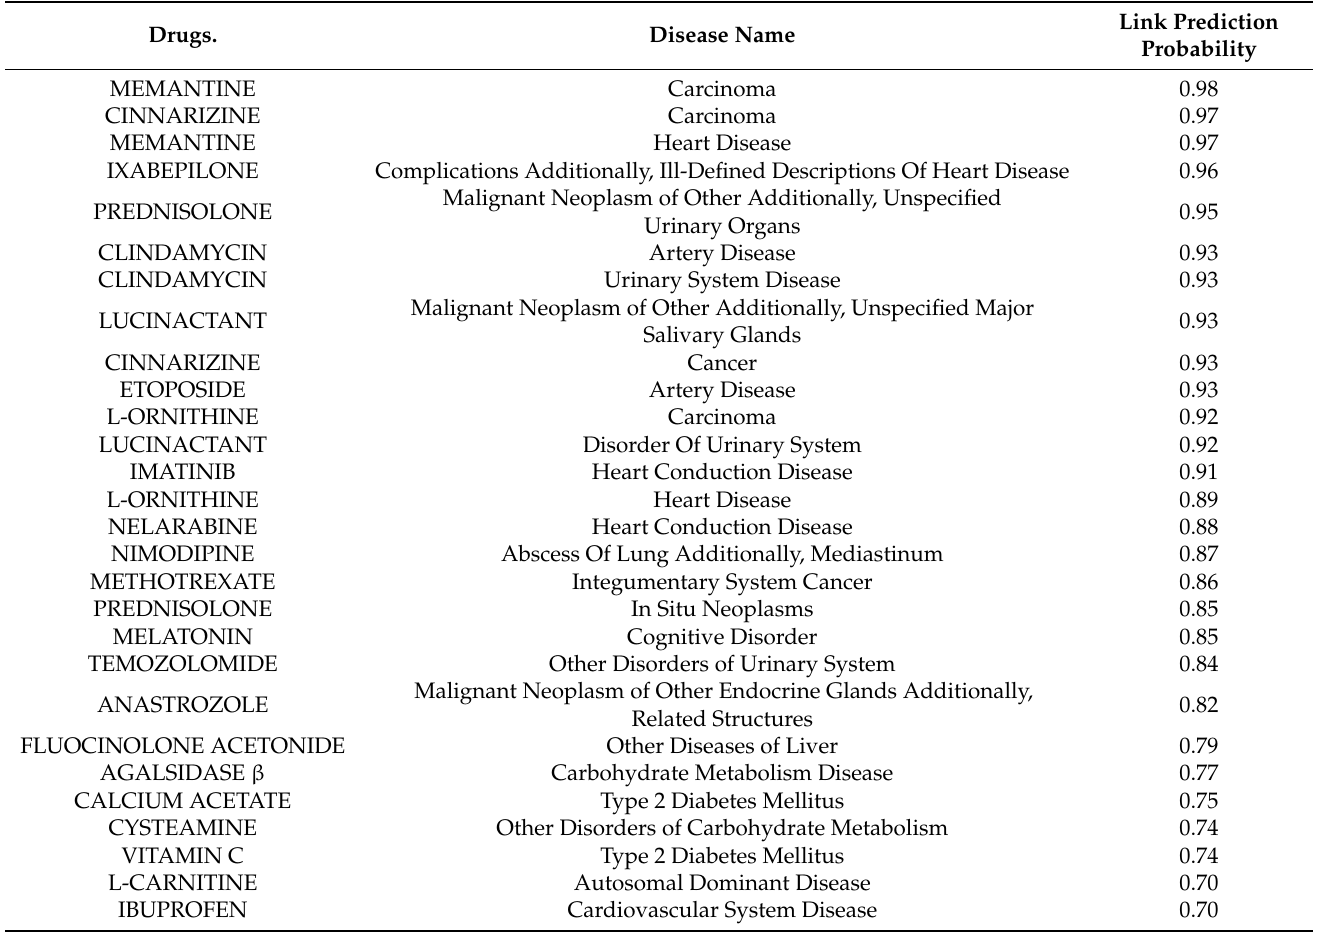
Table 4. Ranking of drugs and diseases with new predicted links using GNN.